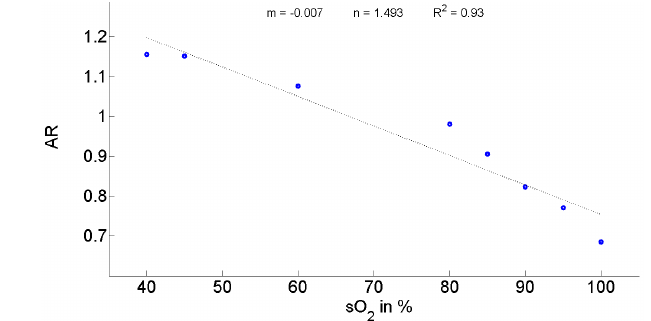
Figure 4. Hyperspectral images of a kidney with color-coded oxy- gen saturation distribution before (a) and after (b) 120min of nor- mothermic machine perfusion. The left side of the image shows the characteristic spectra of one pixel of the corresponding oxygenation status.